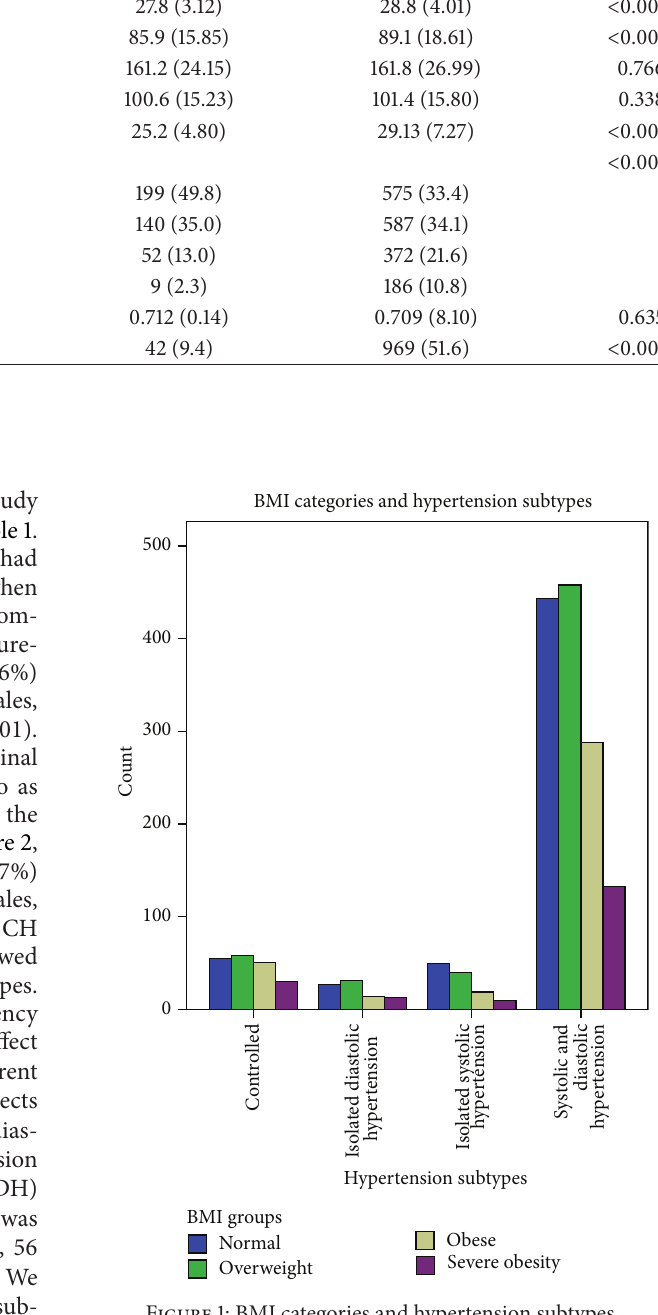
Figure 1: BMI categories and hypertension